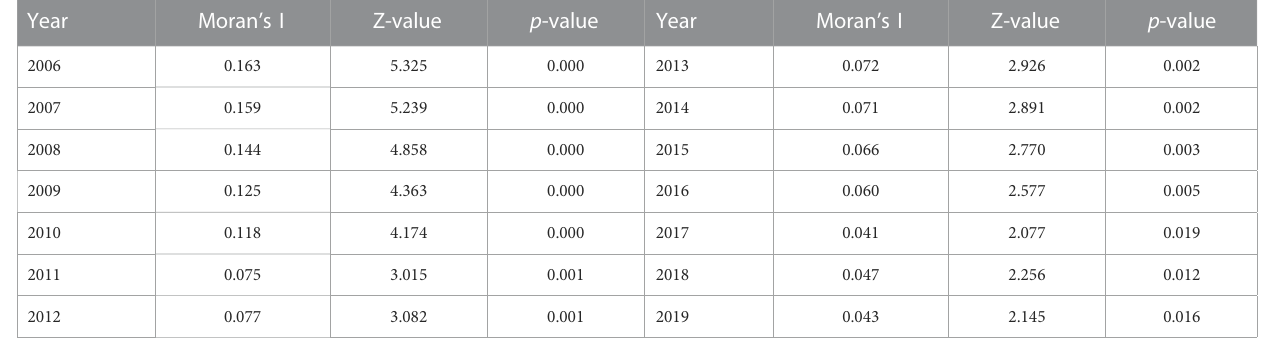
TABLE 2 Moran ’ s I index for lnCEI in China from 2006 to 2019.